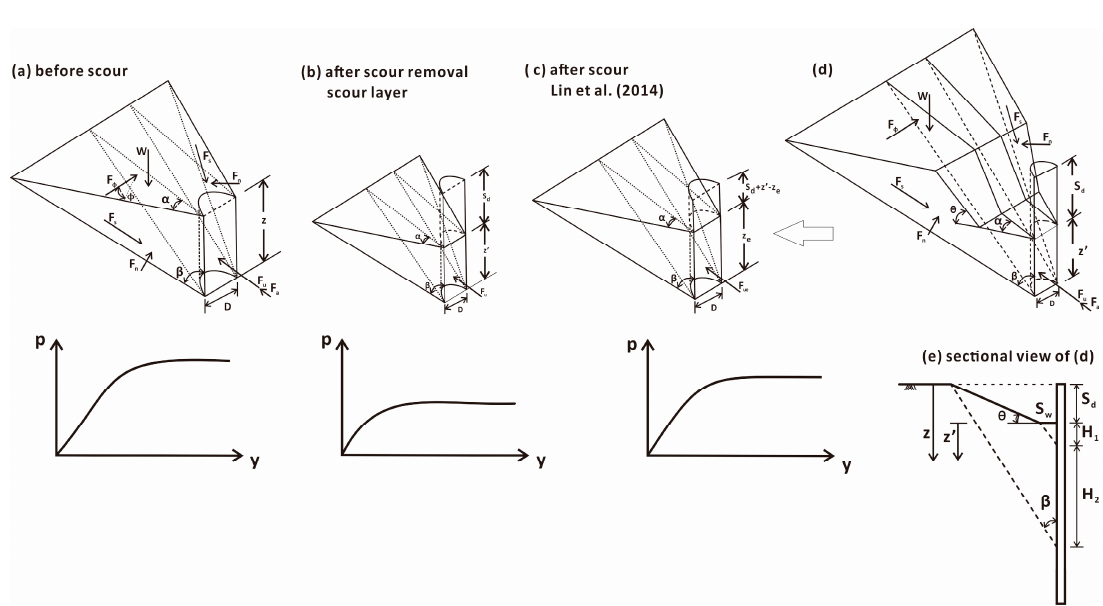
Figure 4. Schematic for damaged soil at a depth of z below the mudline before scour and the p - y curves (suggested by Lin et al. [25]).